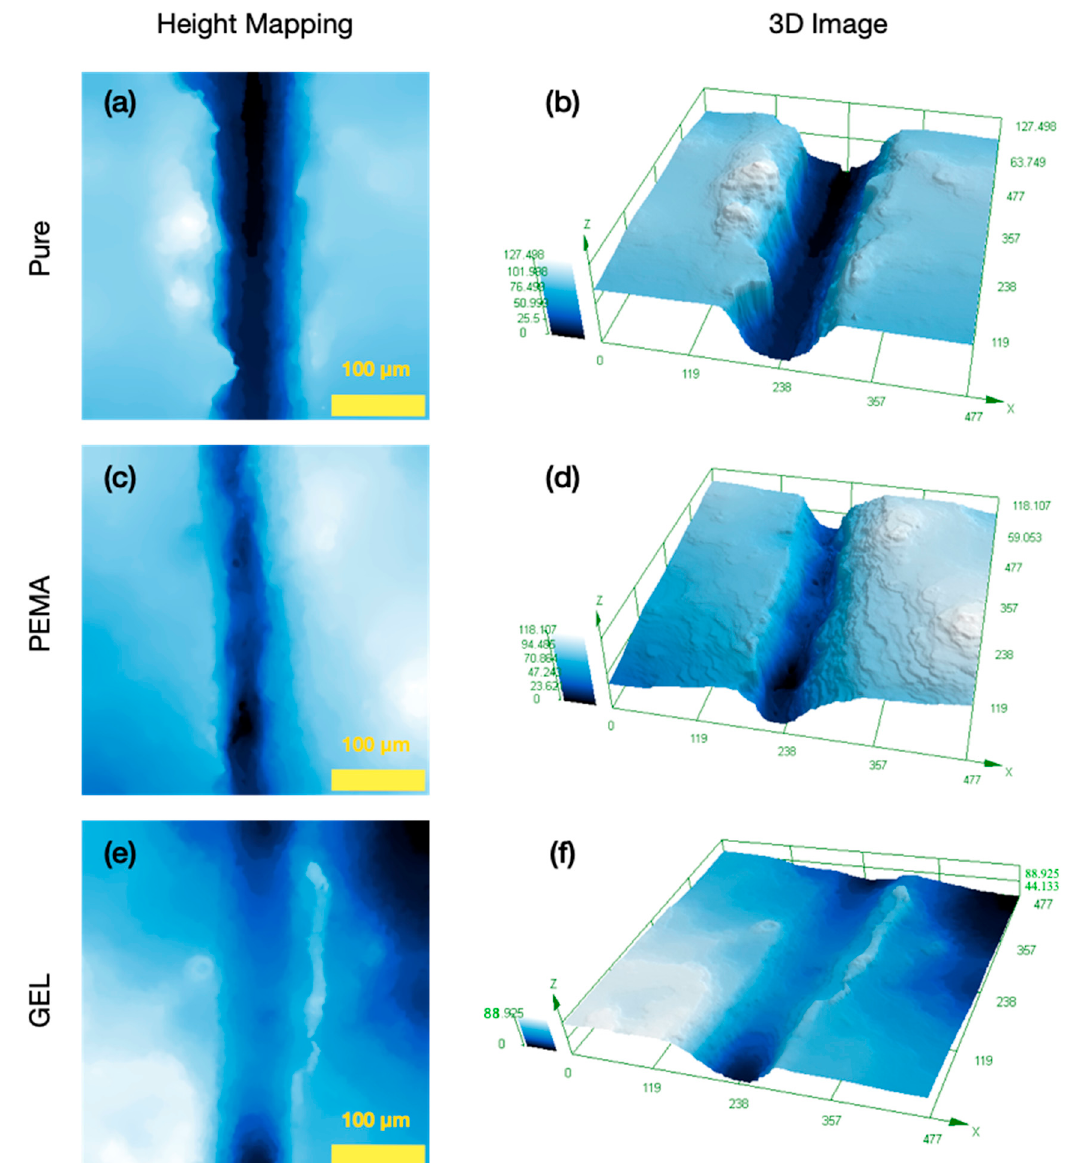
Figure 13. OM imaging of the samples 24-h after the initial scratch; ( a ) pure epoxy primer height